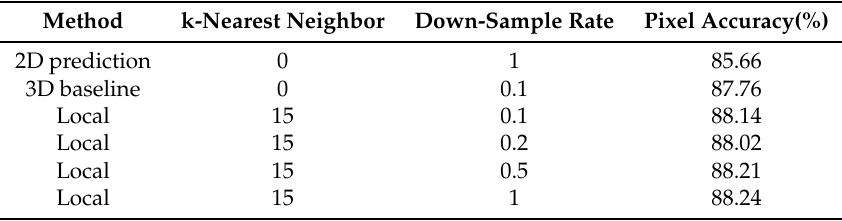
Table 3. Ablation study on Down-sample